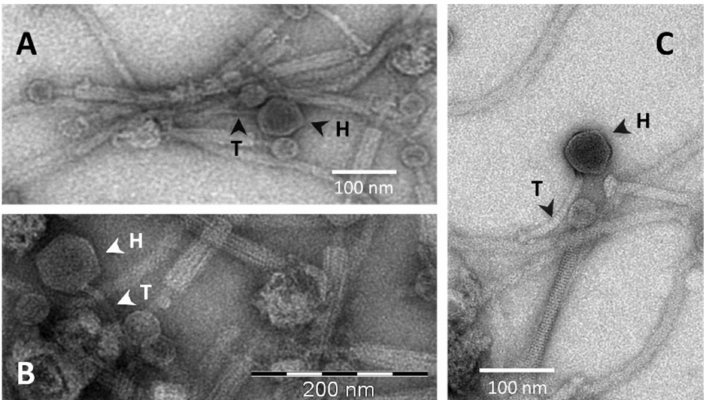
Figure 10. Transmission Electron Microscopy of partially purified (sucrose gradient) bacteriophage- like particles. Apart from Bp15.1PLP, another less abundant phage-like particle was observed. Heads (H) and tails (T) of this particle are shown with